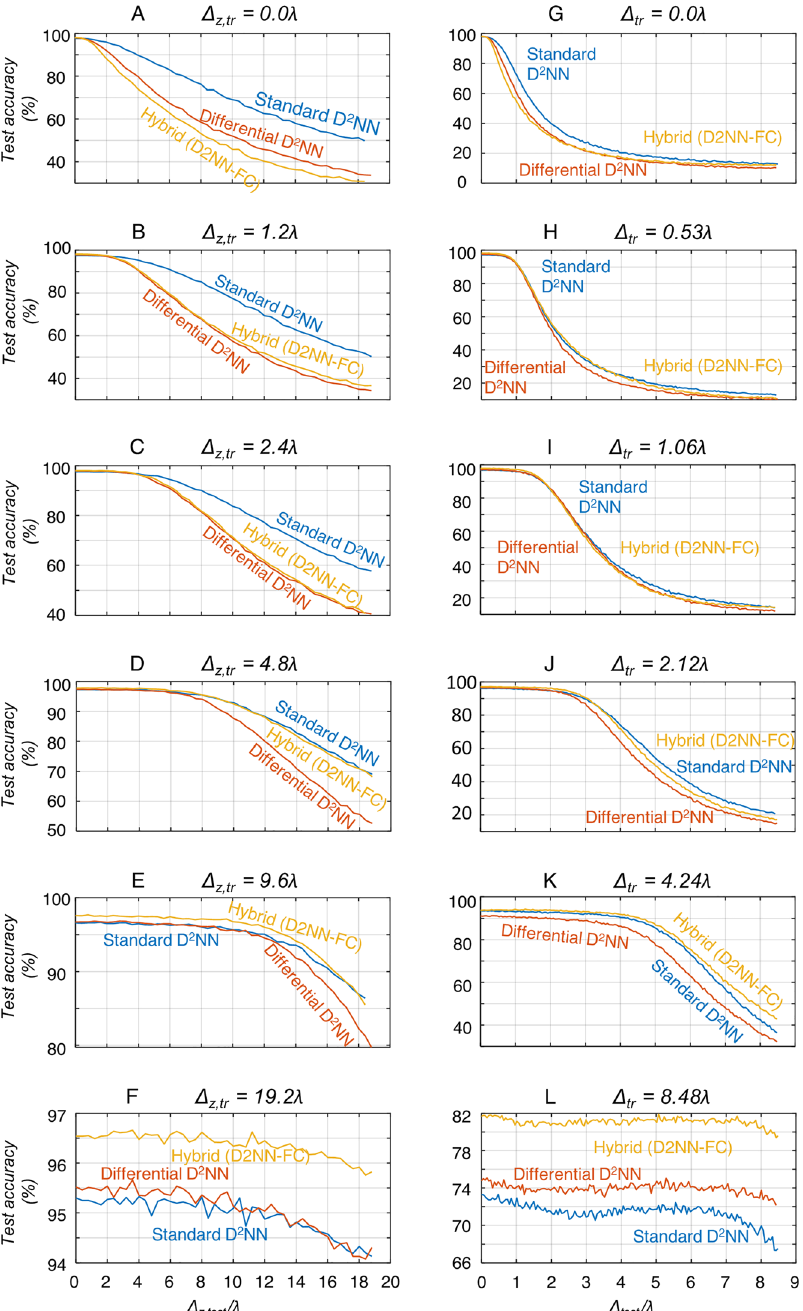
Figure 3: Comparison of different types of D 2 NN-based object classi fi cation systems trained with the same range of mis- alignments. (A) Comparison of error-free designs, Δ z,tr = 0.0 λ , for standard (blue), differential (red) and hybrid (yellow) object classi fi cation systems against different levels of axial misalignments, Δ z,test . (B) Comparison of standard (blue), differential (red) and hybrid (yellow) object classi fi ca- tion systems against different levels of axial misalignments when they are trained with Δ z,tr =1.2 λ .C,D,EandFaresameasB, except during the training of the diffractive determined by Δ z,tr , taken as 2.4, 4.8, 9.6 and 19.2 λ , respectively. (G) Comparison of error-free designs, Δ tr = 0.0 λ , for standard (blue), differential (red) and hybrid